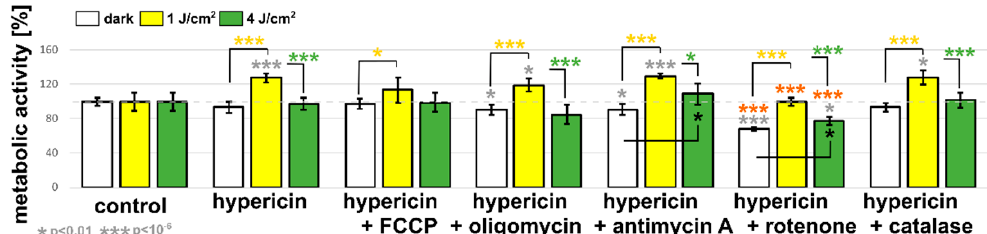
Figure 7. Metabolic activity of U87 MG cells exposed to hypericin and respiratory chain regulators: FCCP, oligomycin, antimycin A, rotenone, and catalase. Cells were treated with the studied molecules in the dark and after irradiation with orange light at 1 and 4 J/cm 2 . The error bars represent the standard deviation from the mean values. The degree of significant difference from the untreated control (gray asterisks), from the hypericin-treated cells (orange asterisks), between samples in the dark and after irradiation of 1 J/cm 2 (yellow asterisks) and 4 J/cm 2 (black asterisks), and between both irradiation groups (green asterisks) was evaluated using one-way ANOVA test: * p < 0.01 and *** p < 10 − 6 .